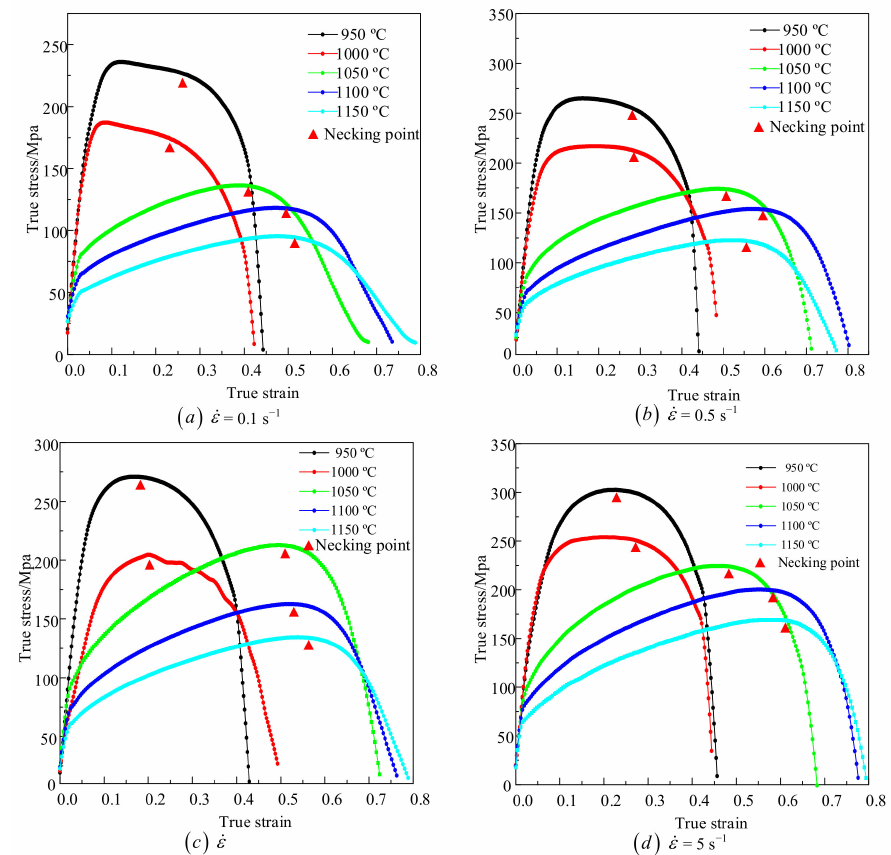
Figure 4. Stress–strain curves from tensile testing at different temperatures and strain rates ( a ) 0.1 s − 1